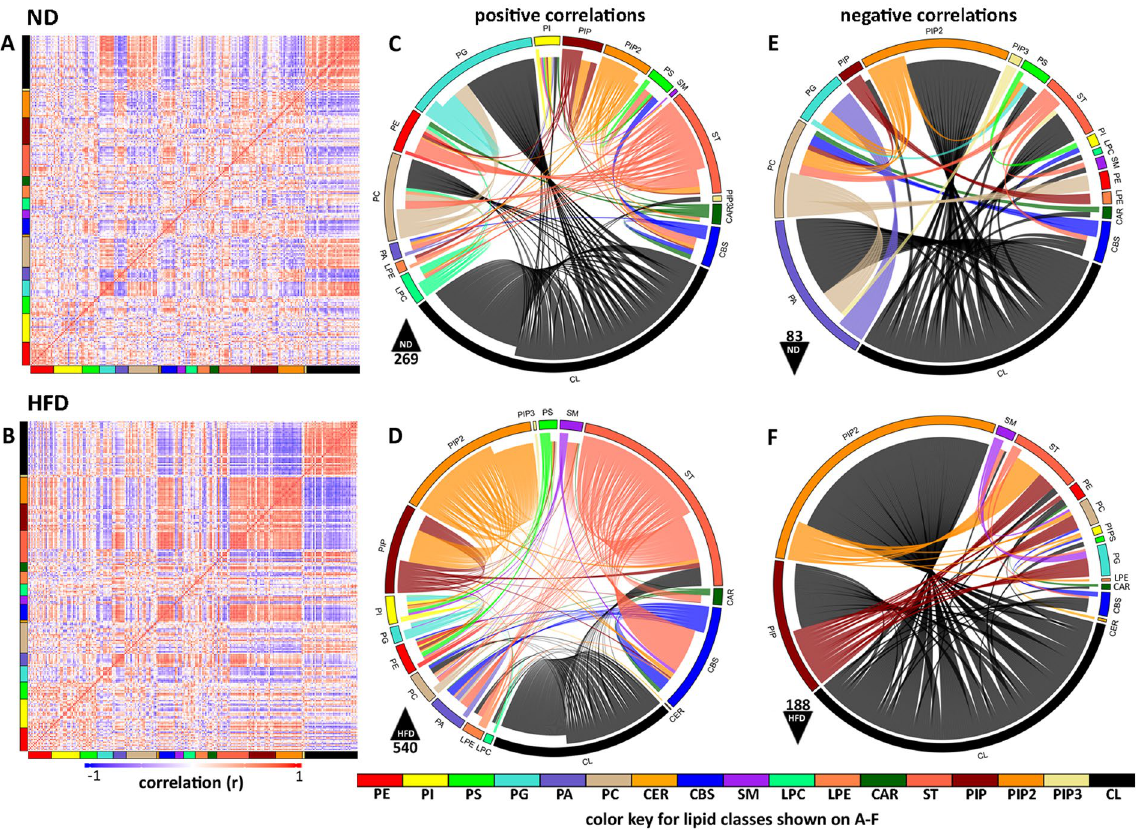
Figure 6. Correlation analysis of brain lipidome in HFD and ND mice. ( A , B ) Correlation matrix sorted by lipid class. Rows and columns correspond to 228 phospholipid species measured in ND ( A ) and HFD ( B ). Color represents the correlation level between lipid pairs. Red denotes a positive and blue a negative correlation. Each lipid class is represented by the corresponding colored bar across the bottom and left side of each square. ( C–F ) Network visualization of correlated lipid pairs in ND and HFD brains (P value > 0.005; r > 0.9 for positive and r < − 0.9 for negative correlations). Chord diagrams show the positively (C and D) and negatively (E and F) correlated pairs of lipid species in ND ( C and E ) and HFD ( D and F ). Each lipid class is represented by a node around the chord diagram and color coded. Lines connecting highly correlated lipid pairs are color coded according to lipid class, with the origins of the lines of correlation being closer and termination points further from the outside nodes. In the bottom left of each diagram the triangle indicates the direction of correlation (positive or negative) and the number specifies the total number of correlations. Color key at the bottom of the figure indicated the lipid classes shown on ( A – F